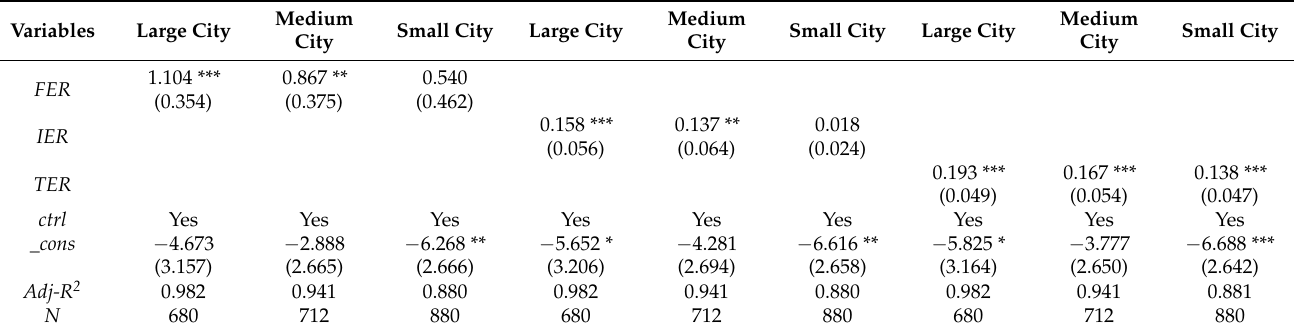
Table 5. Grouping regression results of the large, medium and small